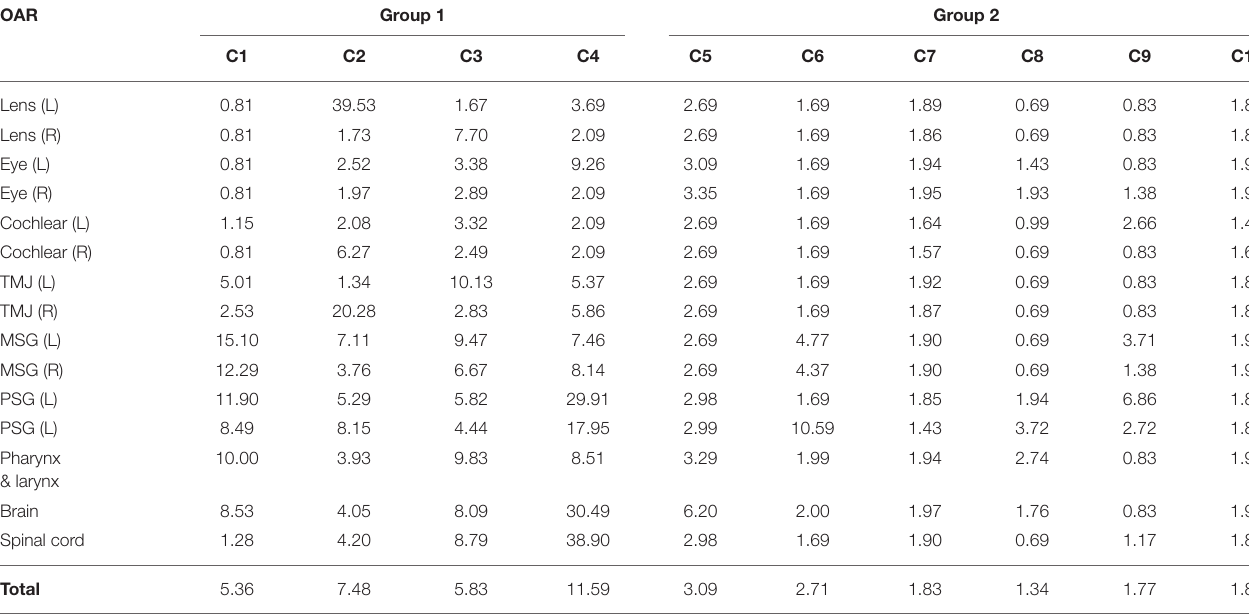
TABLE 4 | Hausdorff distance of each clinical test set obtained from deep-learning-based automatic segmentation. OAR Group 1 Group 2 C1 C2